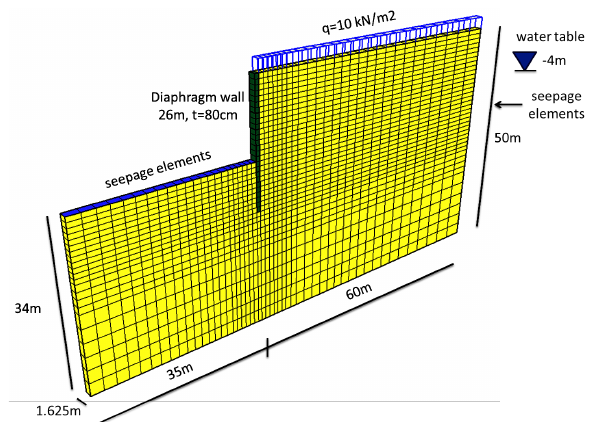
Figure 4: FE model of deep excavation protected with a diaphragm